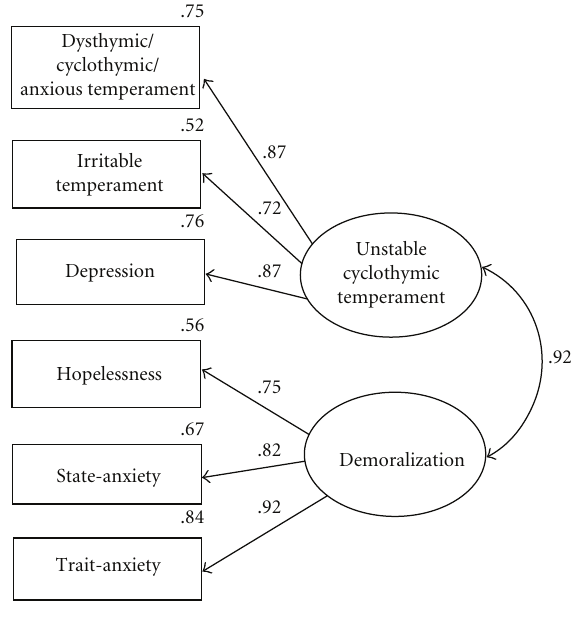
Figure 1: Structural Equation Model with two correlated factors. The curved arrow represents the relationship between the latent factors, while straight arrows from latent factors to observed variables represent factor